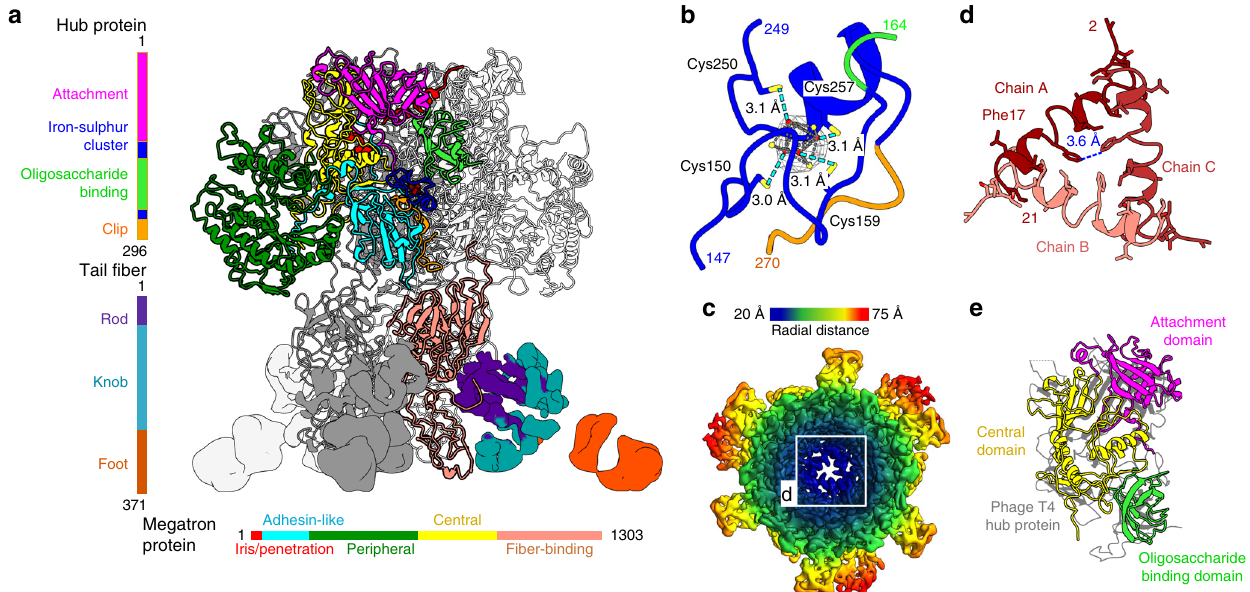
Fig. 5 Structure of the RcGTA baseplate. a Side-view of the RcGTA baseplate. Domains of one hub and one megatron protein are colored according to the sequence diagrams shown on the left and at the bottom of the panel. The iron – sulfur cluster in the hub protein is shown as dark red spheres. Electron densities of tail fi bers are shown. The density of one of the fi bers is colored according to domains as indicated in the sequence diagram on the right of the panel. b Detail of iron – sulfur cluster coordinated by four cysteines of hub protein. The electron density map of the cluster is stronger than that corresponding to the surrounding proteins. Distances between sulfur atoms of cysteine sidechains (yellow) and iron ions (red) are indicated. c Cryo-EM map of the RcGTA baseplate viewed along its axis towards the head is rainbow-colored based on the distance from the threefold axis of the structure. The inset shows detail of the constriction of the central channel formed by iris/penetration domains of megatron proteins. d The iris/penetration domains from three subunits of megatron proteins are differentiated by shades of red. Interatomic distances between sidechains of Phe17 are indicated. e Domain swapping among baseplate proteins of RcGTA and phage T4. Attachment and oligosaccharide-binding domains of the RcGTA hub protein and the central domain of the megatron protein of RcGTA can be superimposed onto the central hub protein of bacteriophage T4 shown in gray (PDB